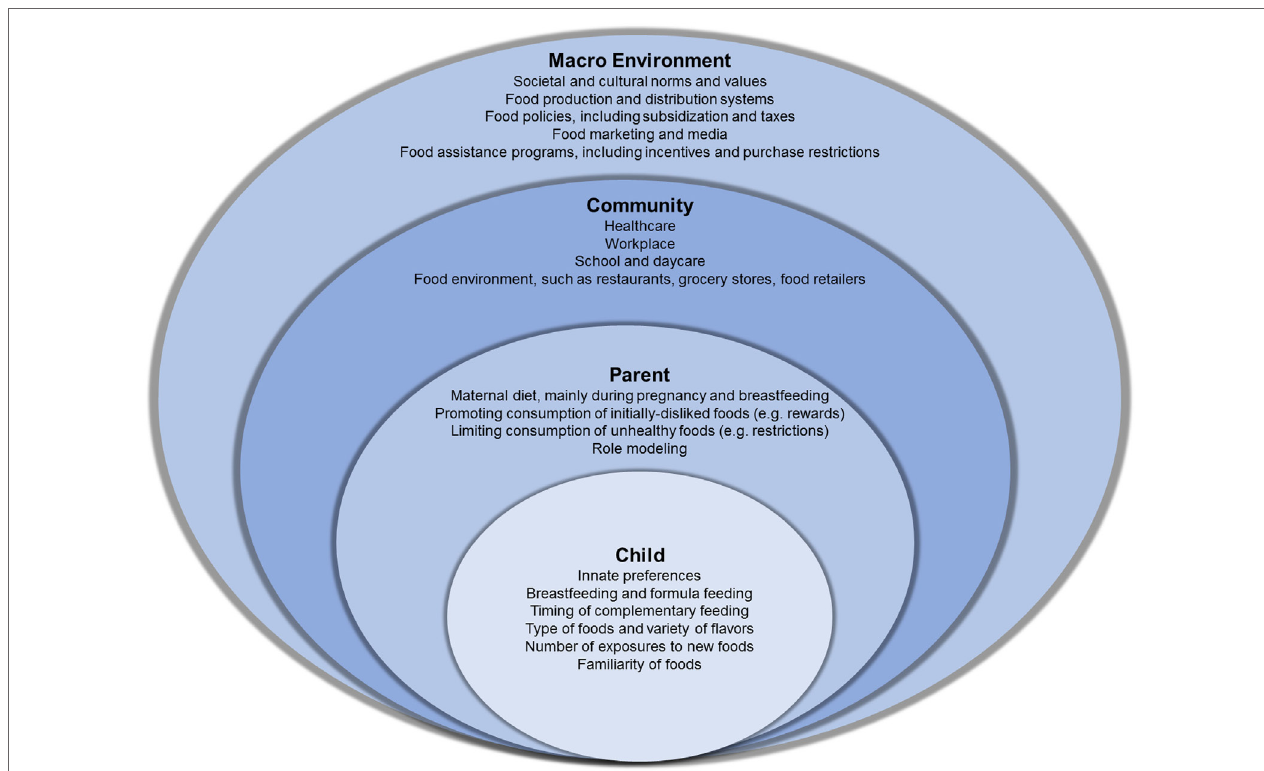
FigURe 1 | An ecological model of the influences on food preferences in children. The child and parent levels describe known factors that shape food preferences in children, starting at birth. The community and macro-environment include factors with known direct effects on food preferences as well as factors that may indirectly influence food preferences through their effects on individual